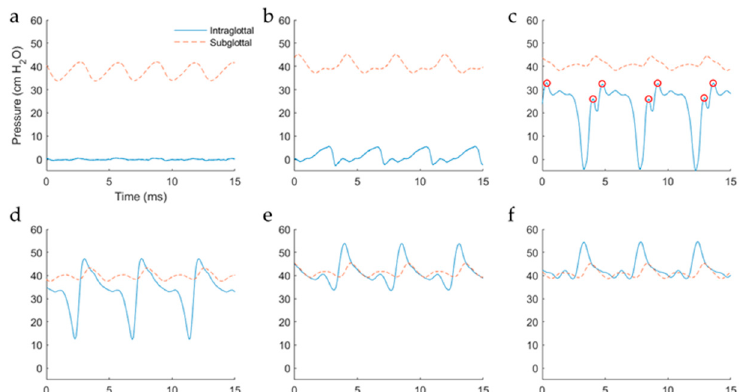
Figure 9. Effect of superior–inferior advancement of the intraglottal and subglottal pressure sensors. Subfigures ( a–f ) are from, respectively, the pressure sensor positions in subfigures ( a – f ) of Figure 8. The intraglottal pressure sensor was confirmed to be in the phonatory strike zone in ( c ) with vocal fold collision instants indicated (red circles).